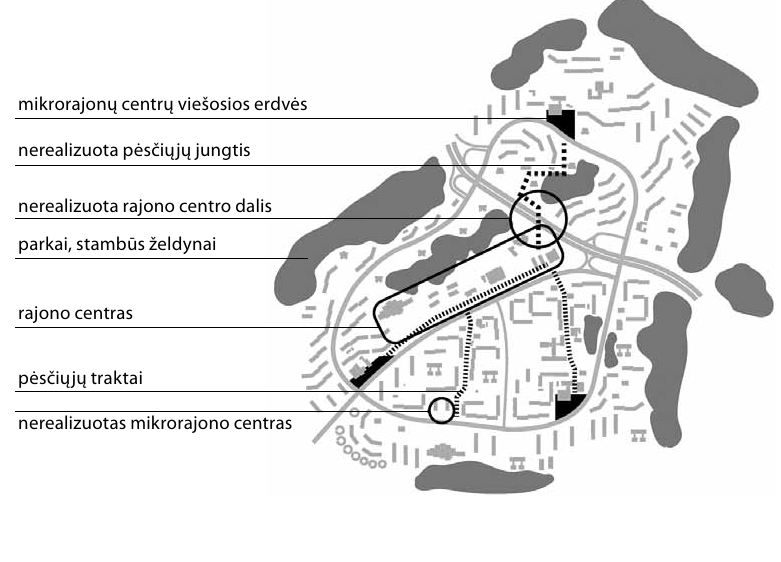
Fig. 2. Main Elements of Public Space